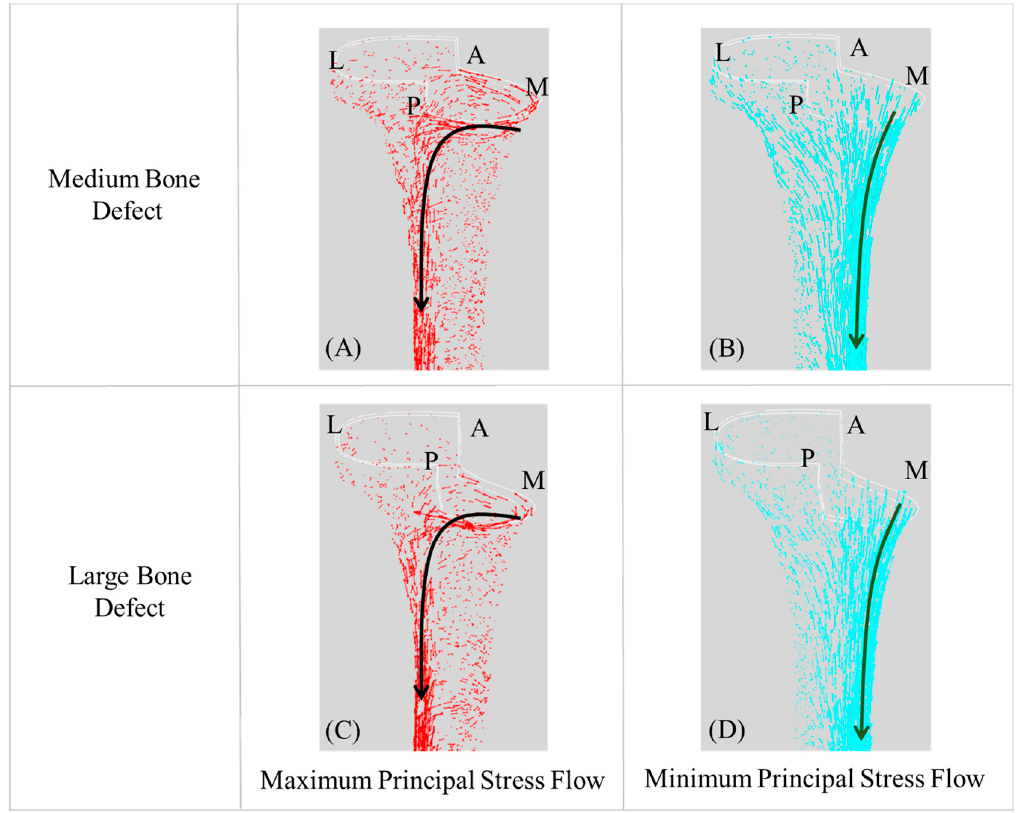
Figure 5. Representative maximum principal stress flows for the metal block augmentations of the ( A ) medium and ( C ) large uncontained bone defects and minimum principal stress flows for the metal block augmentations of the ( B ) medium and ( D ) large uncontained bone defects anterior cortex line. (A, anterior; M, medial, L, lateral; P, posterior regions).